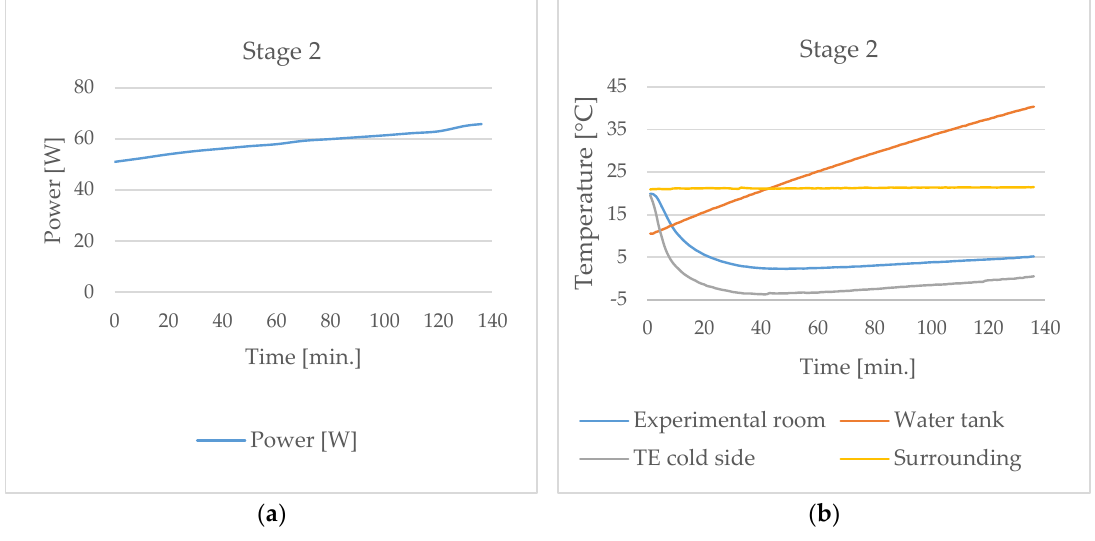
Figure 5. The results obtained during the measurements conducted at Stage 2: ( a ) mean power supplied to the TE module; ( b ) mean temperature values measured at fix points of the experimental set.